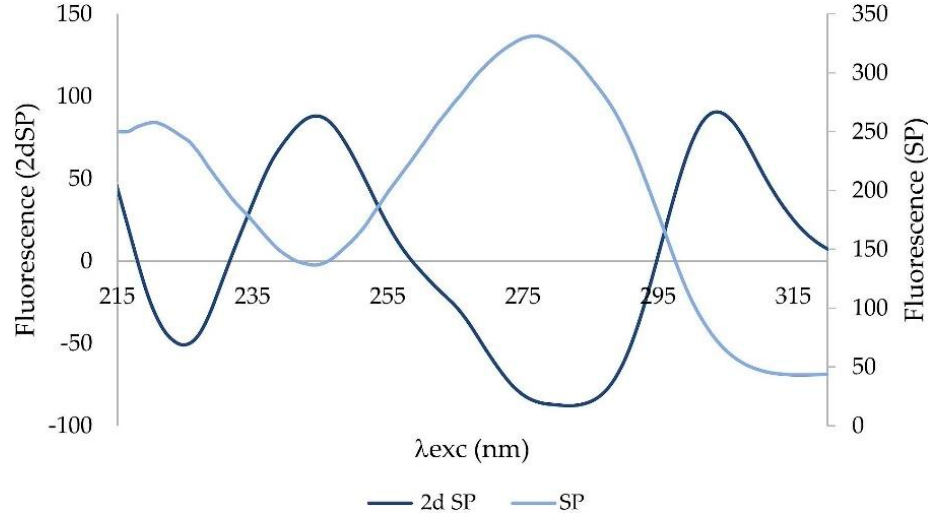
Figure 4. Synchronous profile (SP) of tear fluid and its second derivation (2dSP). The second derivative was applied to a synchronous profile, not to the synchronous spectrum Δλ = 110 nm. The 2D synchronous spectrum increased differences between profiles of CTRL and POAG (Figure 5). The derivative spectrum consists of two concave curves, (denoted “+1” and “+2”) and two convex curves (“ − 1”; “ − 2”). The peaks “ − 1”, “+1”, and “ − 2” show the largest differences in the shape of the curve and/or the position of the minimum and maximum, respectively. The “ − 1” peak reflects the “redshift” of the POAG non-derivative synchronous profile wavelength (Figure 3).